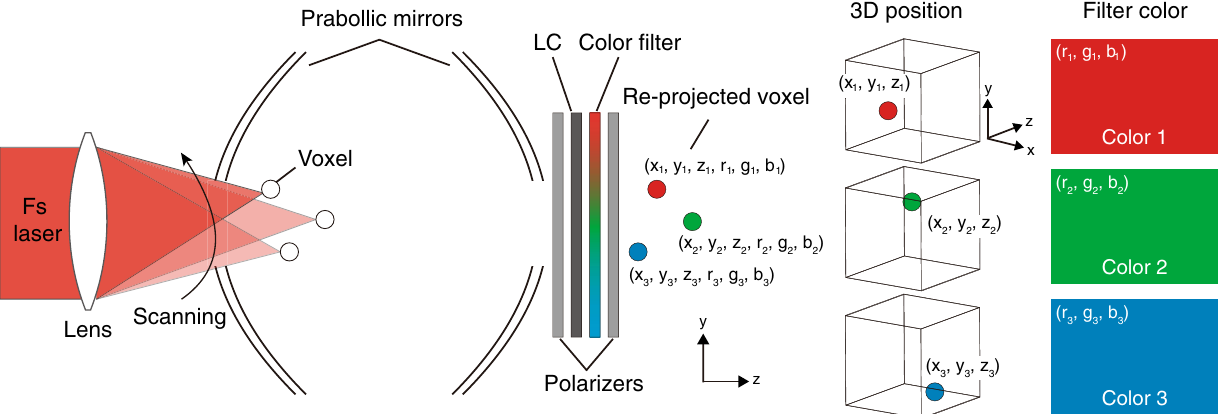
Figure 2. Spatial generation of aerial voxels with arbitrary colors. A voxel re-projected by parabolic mirrors is controlled in terms of its spatial position ( x , y , z ) color using beam scanning and a liquid crystal (LC) color filter ( r , g , b ). This figure was created using Adobe Illustrator 2021 version 25.4.1 (https:// www. adobe. com/ produ cts/ illus trator.